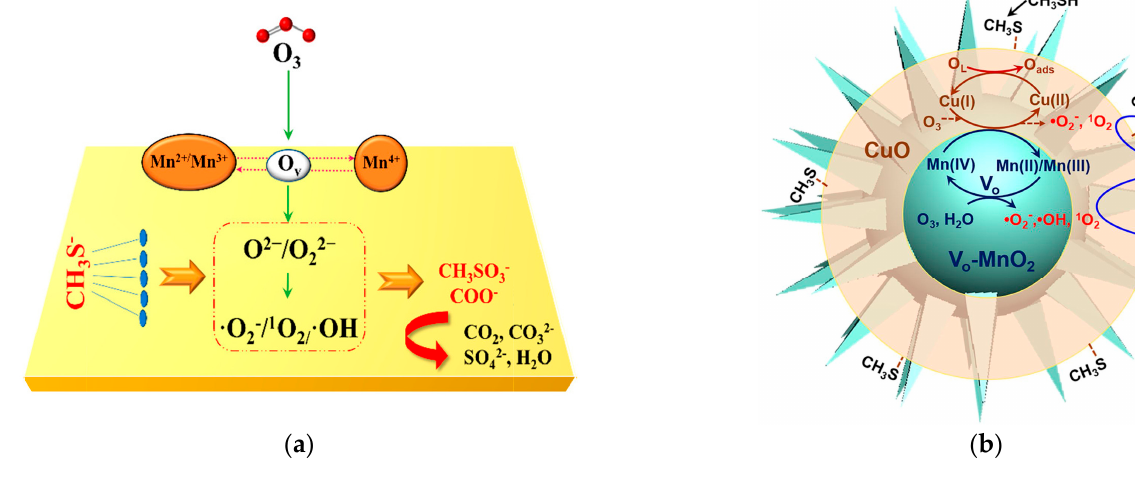
Figure 2. Reaction mechanism of methyl mercaptan catalytic ozonation at ambient temperature: ( a ) use of α -MnO 2 catalyst. Reprinted with permission: American Chemical Society 2020 [81]; ( b ) use of CuO/V O -MnO 2 catalyst, reprinted with permission: Elsevier 2020 [83].